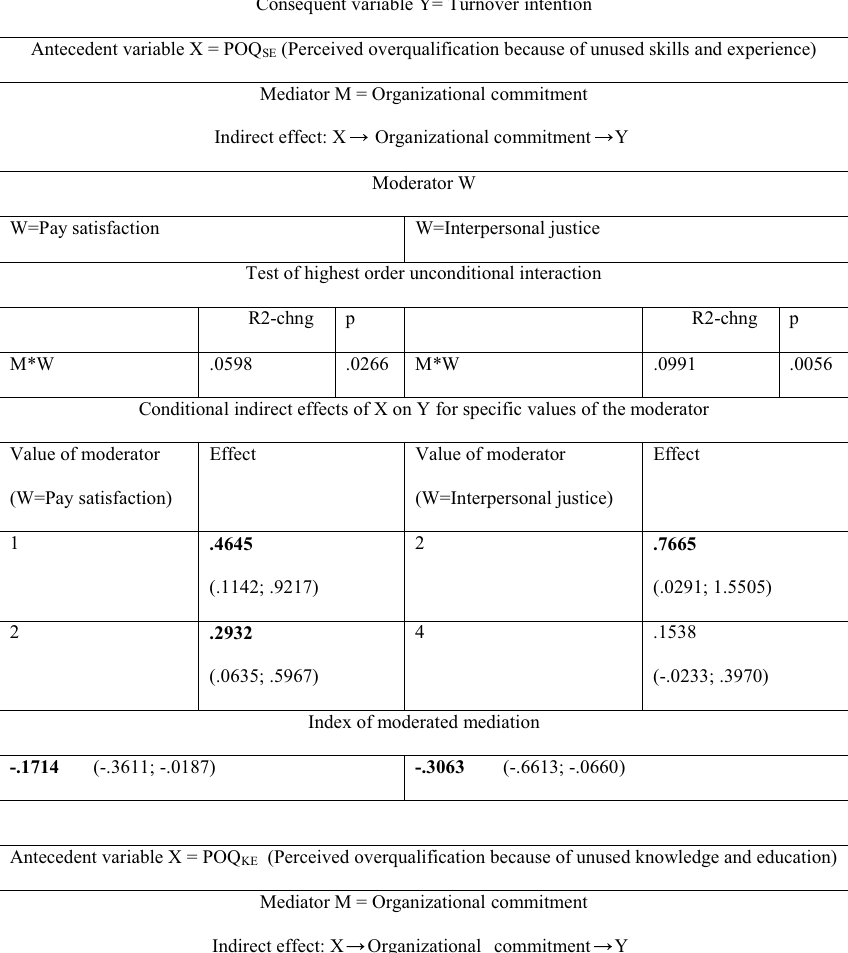
Table 3 Conditional indirect effect of Perceived overqualification (because of unused skills and experience, POQ knowledge and education, POQ ) on Turnover intention ; moderators: Pay satisfaction and Interpersonal justice (respect from KE